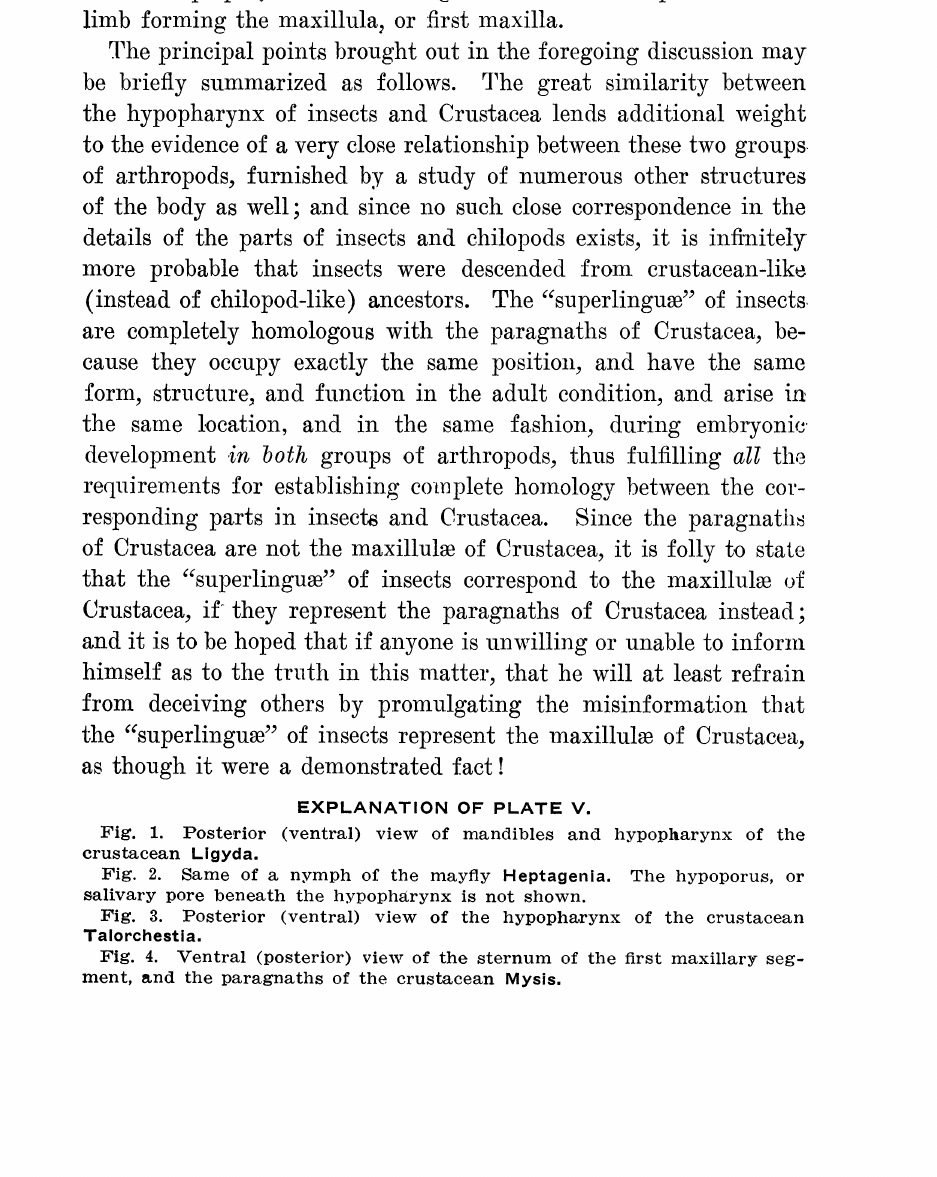
Fig. 3. Posterior (ventral) view of the hypopha.rynx of the crustacean Talochestia. Fig. 4. Ventral (posterior) view of the sternum of the first maxillary seg- ment, and the paragnaths of the